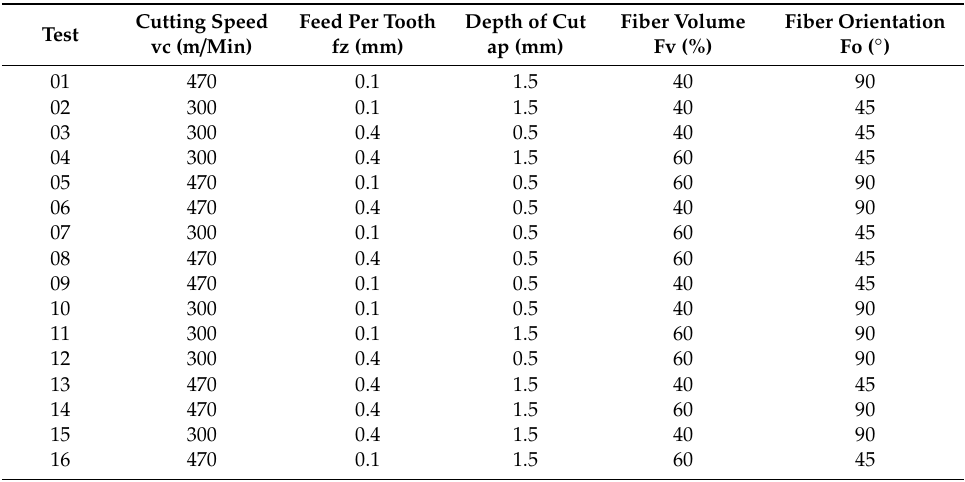
Table 2. Experimental